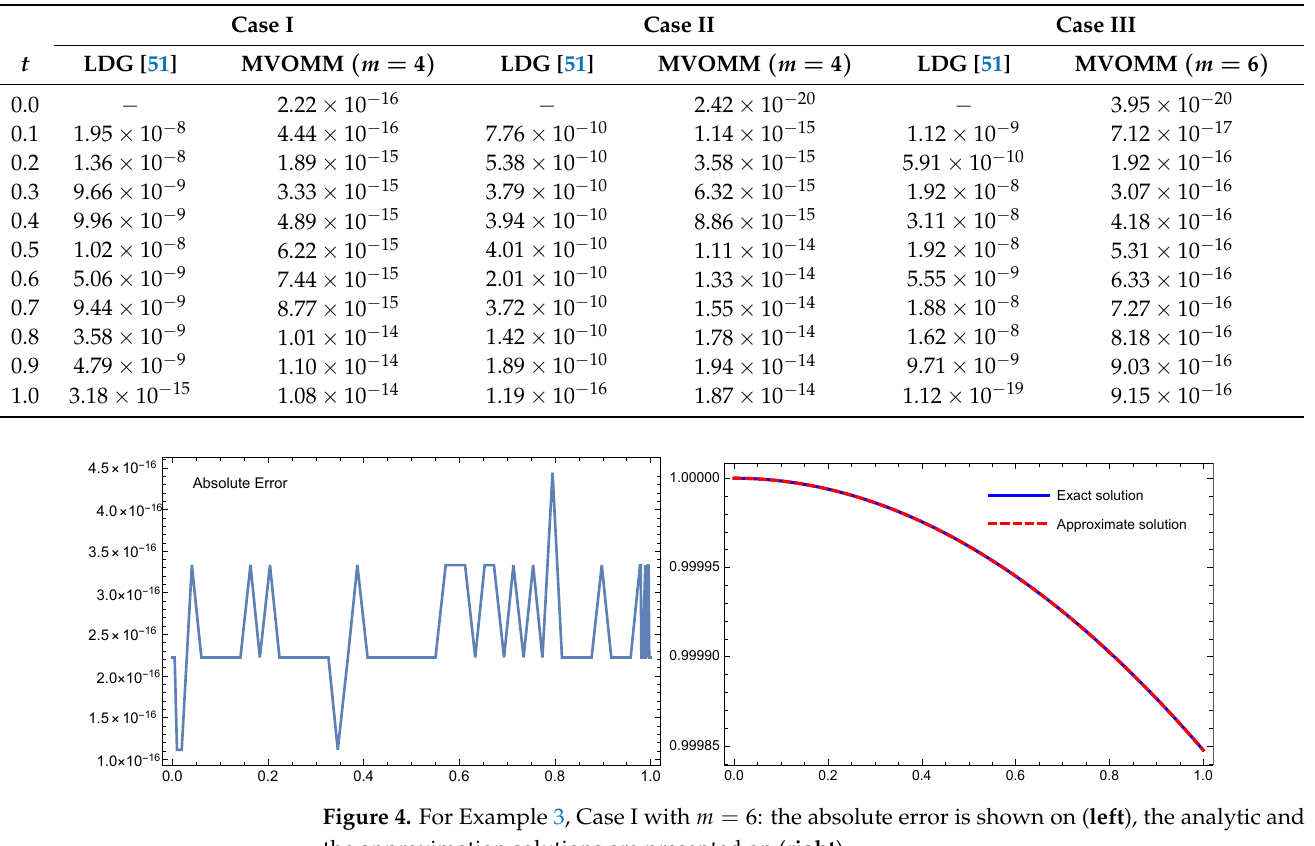
Table 4. Absolute error comparisons for the presented method for Example 3.